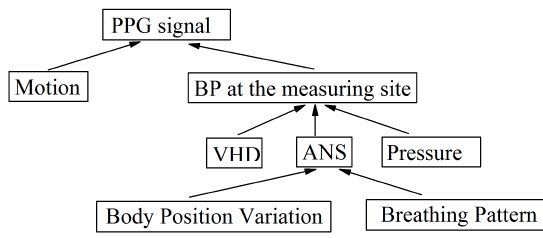
Figure 19. Factors which can affect PPG signals.